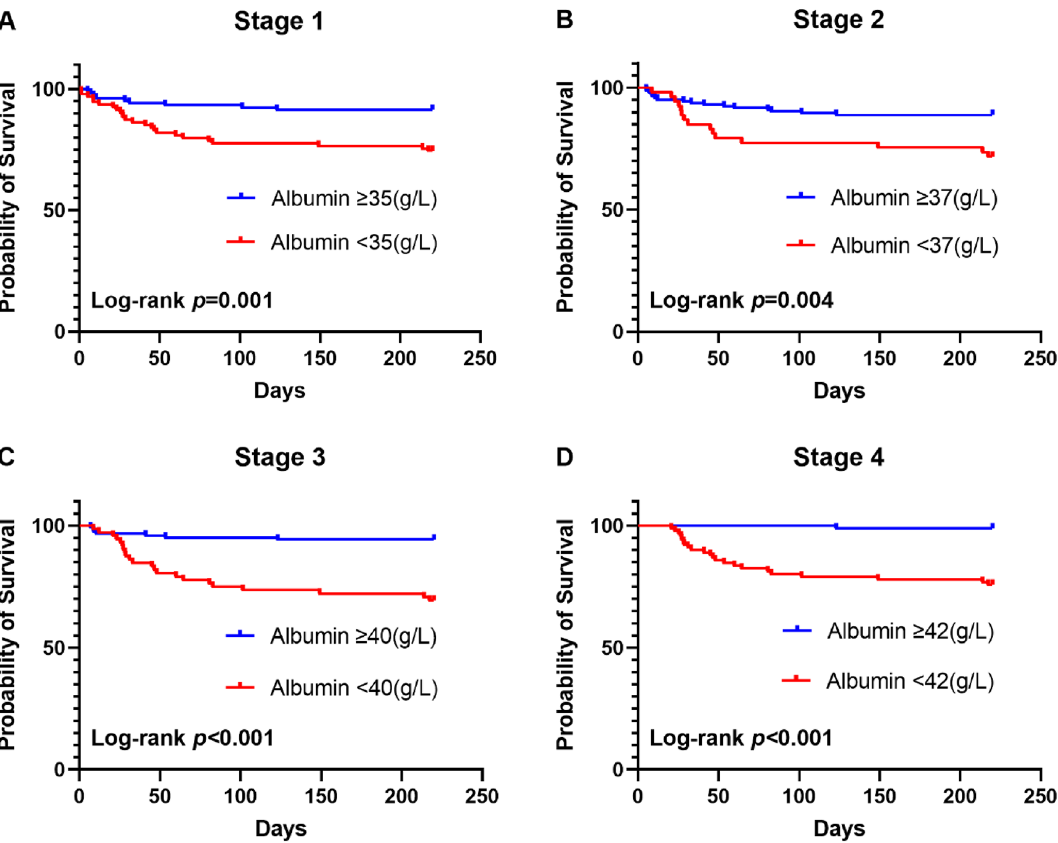
Figure 4. Kaplan–Meier 240-day survival between albumin target and non-target groups at different stages in patients with severe acute